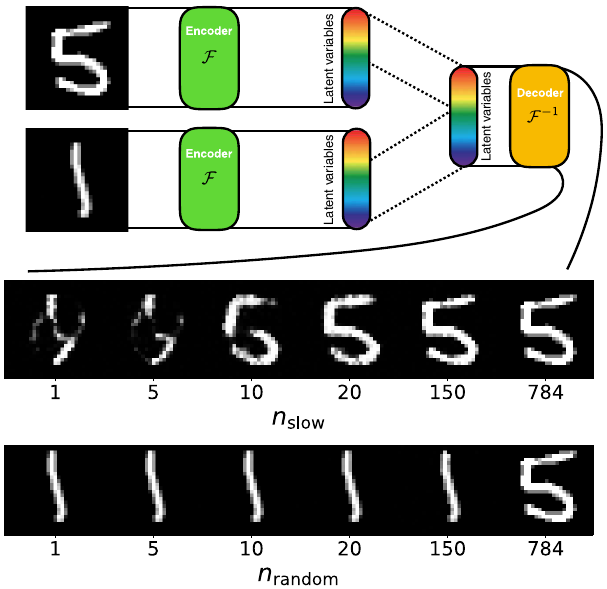
FIG. 8. The coordinate transformation Eq. (2) maps the MNIST images to a latent representation with independent frequency modes. We concatenate slow latent variables of an image together with the fast modes of another image and then map the combined latent vector back to the image space with the inverse coordinates transformation. The bottom panel shows the same experiment by concatenating latent vectors at random.